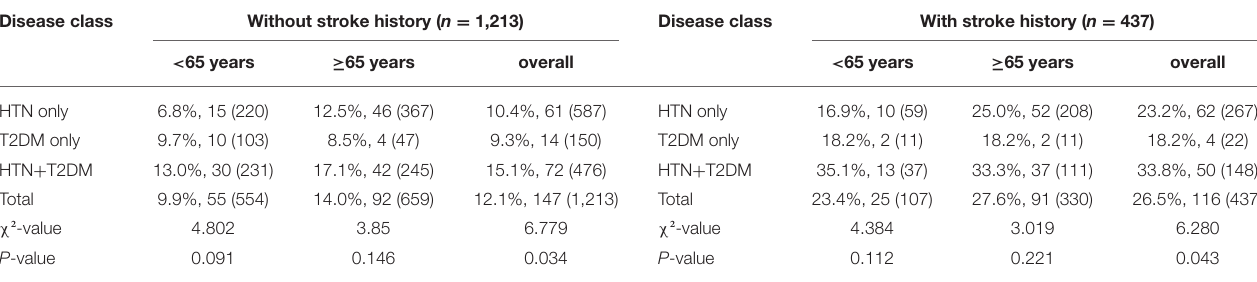
TABLE 3 | Incidence and recurrence rates of stroke by age groups and disease class. Disease class